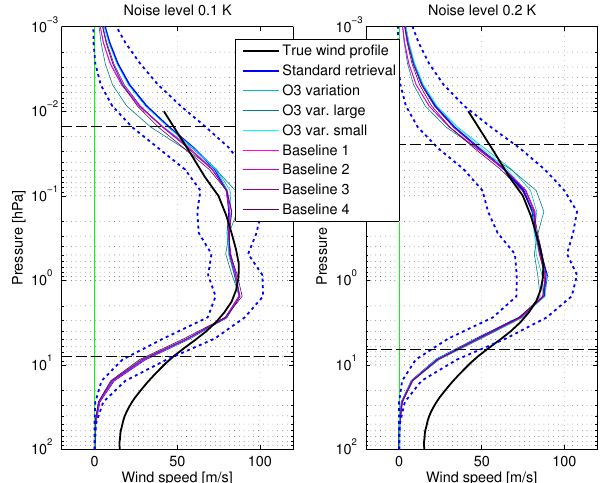
Figure 11. As Fig. 10 but for the new single sideband receiver. This plot moreover contains the mean profiles resulting from retrievals with perturbed forward model parameters.